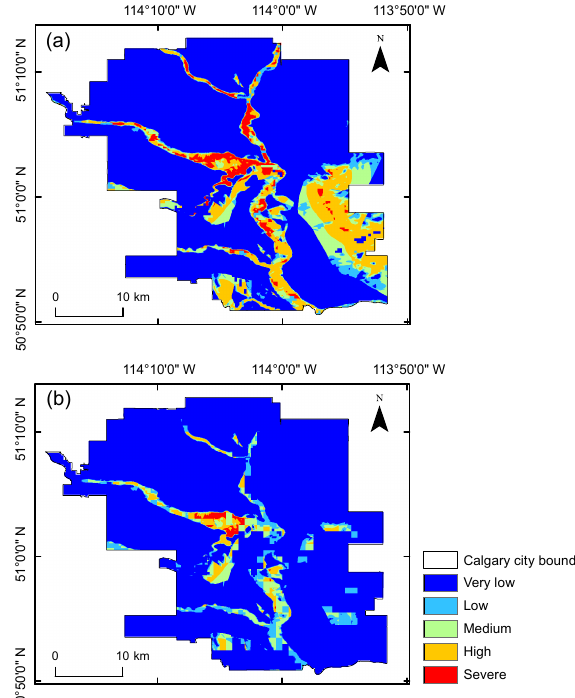
Figure 10. Flood risk map of Calgary: (a) without population in- formation, and (b) with population. Areas around the centre of the city with high rises and dense population remain in the severe risk category, whereas northern and southern parts, which are mainly commercial, change to reduced levels of social